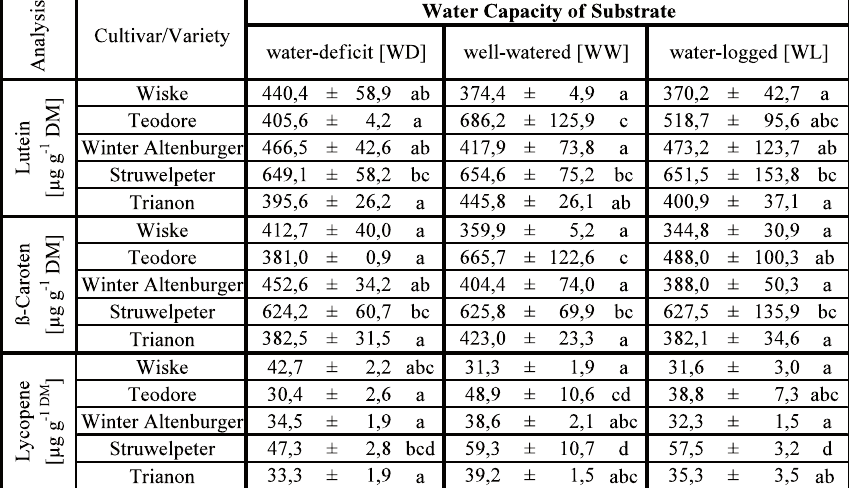
significant differences (Dunett’s T3 test, p ≤